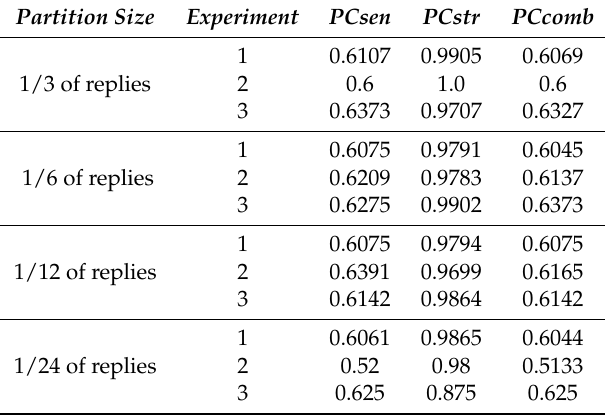
Table 2. Experimentation with the corpora Star